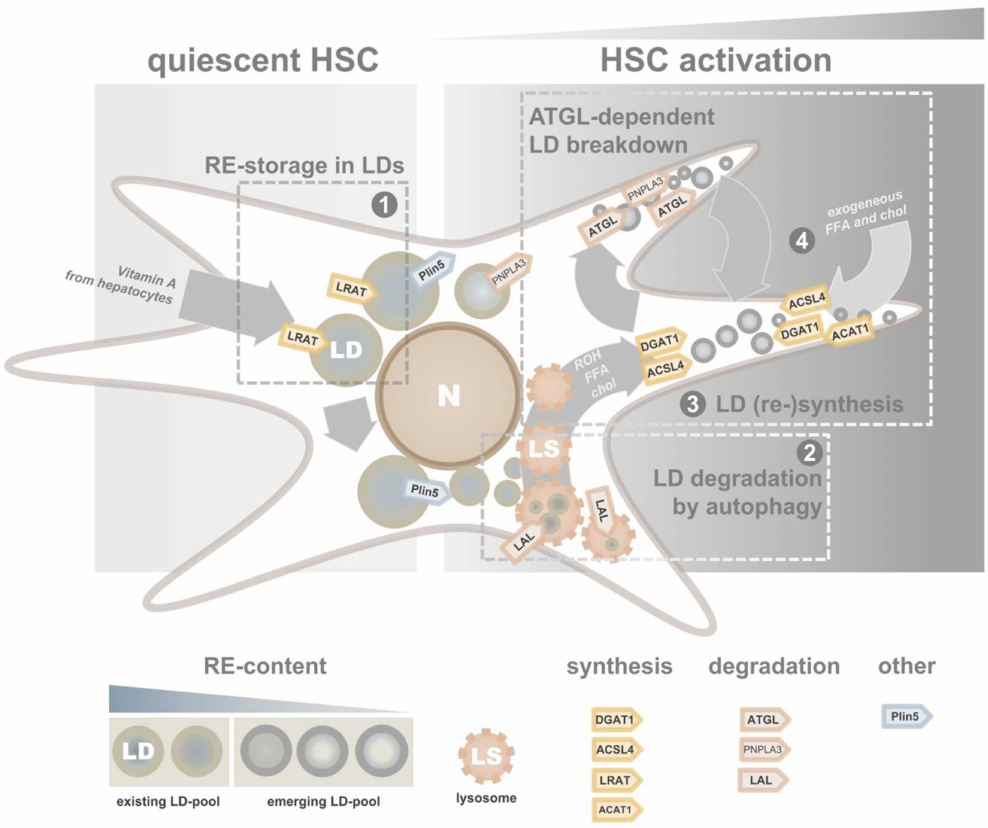
Figure 3. Lipid droplet dynamics in quiescent and activating hepatic stellate cells. HSCs have two distinct metabolic LD pools: “original” LDs, associated with quiescent HSCs ( left ) and “new” LDs that emerge during HSC activation ( right ). While “original” LDs ( 1 ) are predominantly degraded by lysosomes ( 2 ), “new” LDs are quickly recycled by repetitive synthesis by ACSL4 and DGAT1 ( 3 ) and degradationbyneutrallipases( 4 ) . ACSL4, long-chainfattyacid:CoAligase4; ATGL,adiposetriglyceride lipase; chol, cholesterol; DGAT1, diacylglycerol acyltransferase 1; FFA, free fatty acid; HSC, hepatic stellate cell; LAL, lysosomal acidic lipase; LDs, lipid droplets; LRAT, lecithin retinol acyltransferase; LS, lysosome; N, nucleus; PLIN5, perilipin 5; RE, retinyl ester; ROH,